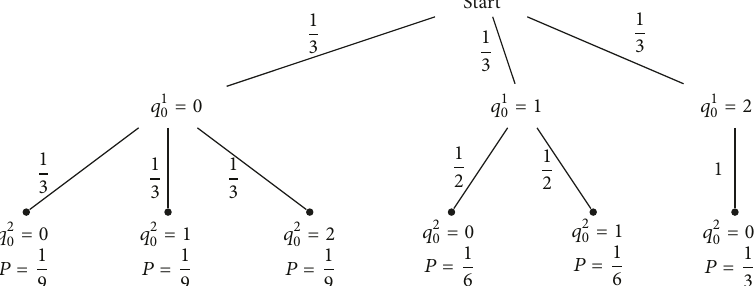
Figure 1: Probability tree for the case of randomizing over quantities for 𝑆 0 = 2 and 𝑇 = 2 . In the case where the level- 0 player picks a strategy at random, all strategies would have the same probability of 𝑃 = 1/𝑛 ℓ = 1/6 . In the alternative case shown in this figure, the player picks between all available quantities in each period with the same probability. This leads to a different distribution of probabilities over the strategies, as shown in the tree.